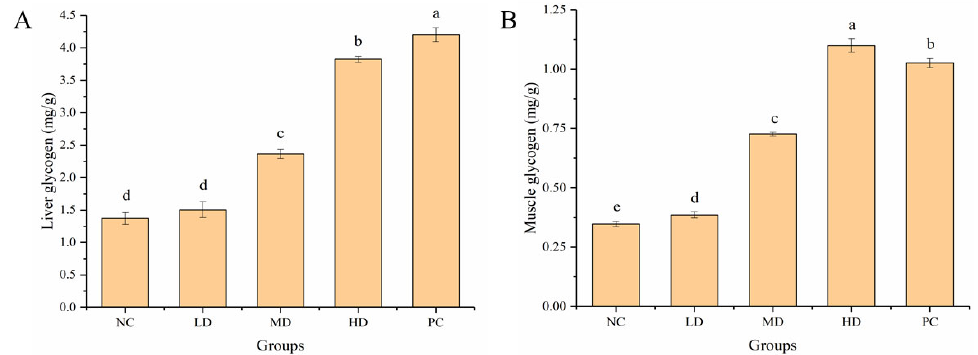
Figure 6. Effect of HGP on liver and muscle glycogen. ( A ) Liver glycogen (LG) of mice from different groups. ( B ) Muscle glycogen (MG) of mice from different groups. Different lowercase letters represent significant differences between groups ( p < 0.05). NC: normal control, LD: low dose, MD: middle dose, HD: high dose, PC: positive control.